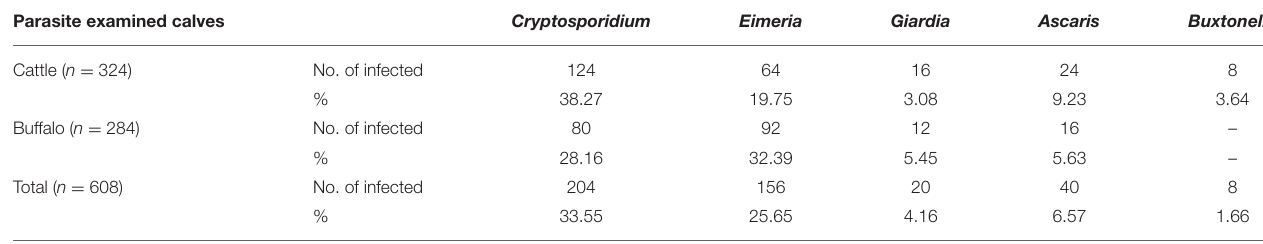
TABLE 5 | Prevalence of different parasites in both cattle & buffalo calves.